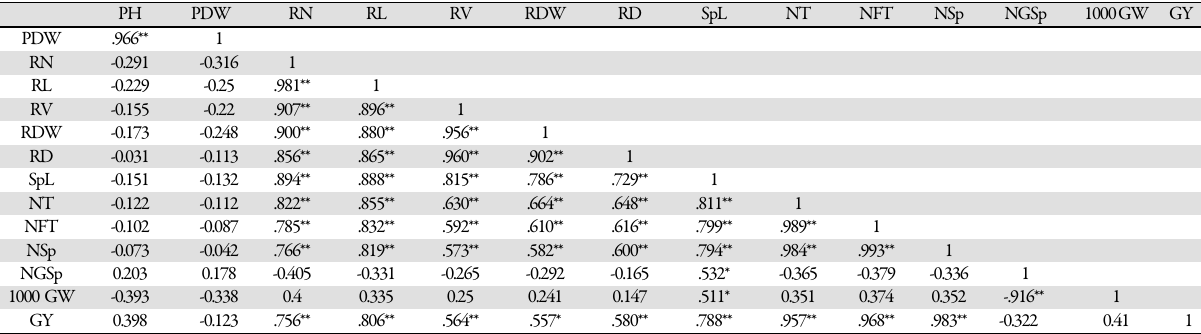
Table 2. Correlation analysis between the studied traits with grain yield under normal irrigation